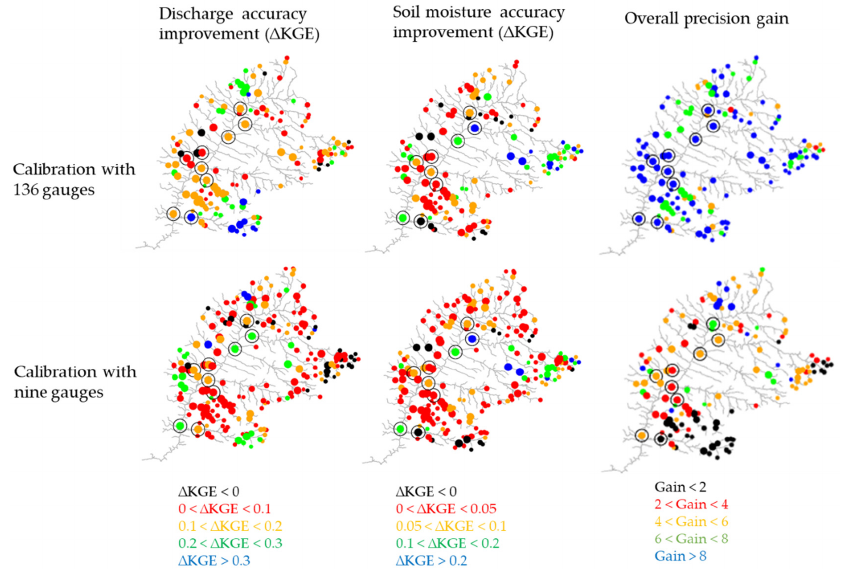
Figure 9. Spatial assessment of discharge and soil moisture accuracy improvements ( ∆ KGE) and overall precision gain when performing calibrations with nine and 136 gauges. The results are presented for the calibration scenario with both discharge and soil moisture (CAL-DS), while the results for CAL-D and CAL-S scenarios are shown in Supplementary Figures S8 and S9. The circle size refers to the gauge drainage area, while the black open circles are the locations of the nine gauges. A maximum circle size is limited for drainage areas > 10,000 km 2